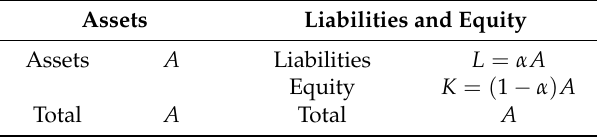
Table 1. The life insurance company’s balance sheet at t =